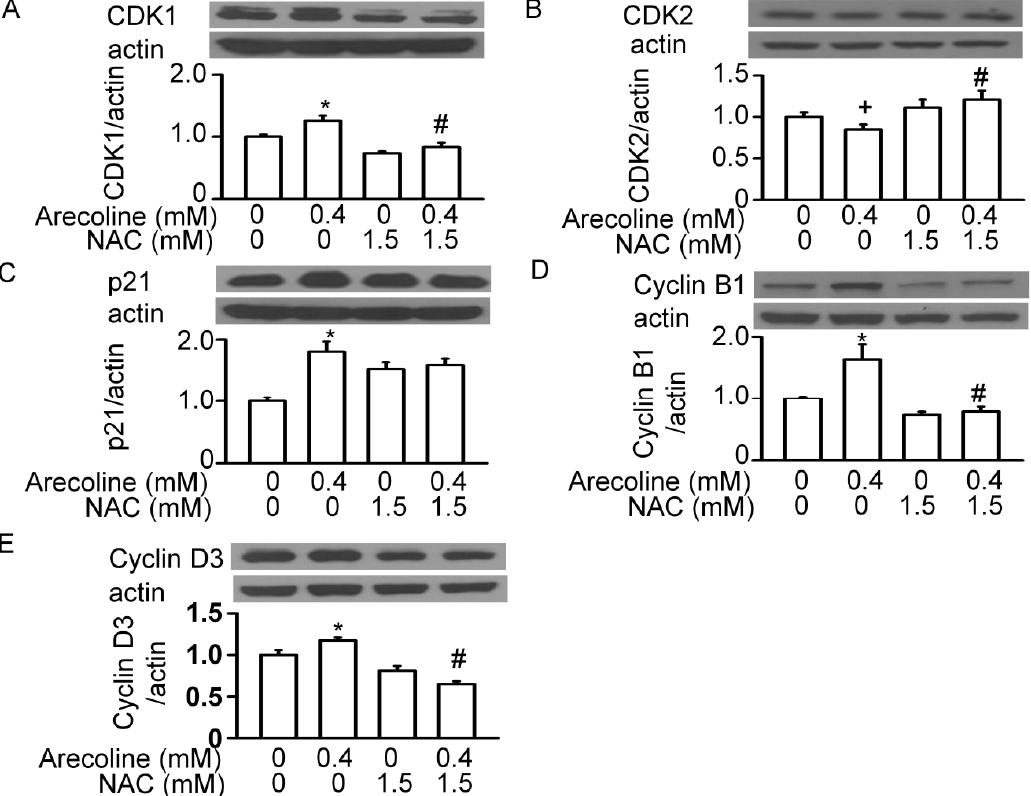
Figure 8. N-acetylcysteine (NAC) blocked the arecoline-induced alterations in the levels of cell cycle regulatory proteins, such as CDK1 ( A ), CDK2 ( B ), p21 ( C ), Cyclin B1 ( D ) and Cyclin D3 ( E ), in normal RWPE-1 prostate cells. Cells were pretreated with NAC for 1 h and then exposed to 0.4 mM arecoline. After 24 h of treatment, proteins were examined by Western blot analysis, and their levels were then expressed after normalization to actin expression. Data are expressed as the mean ± SEM from triplicate experiments; each result was pooled from the data of four 10 cm culture plates. * p < 0.05 vs. the control; + p < 0.05 vs. the control; # p < 0.05 arecoline vs. NAC + arecoline.